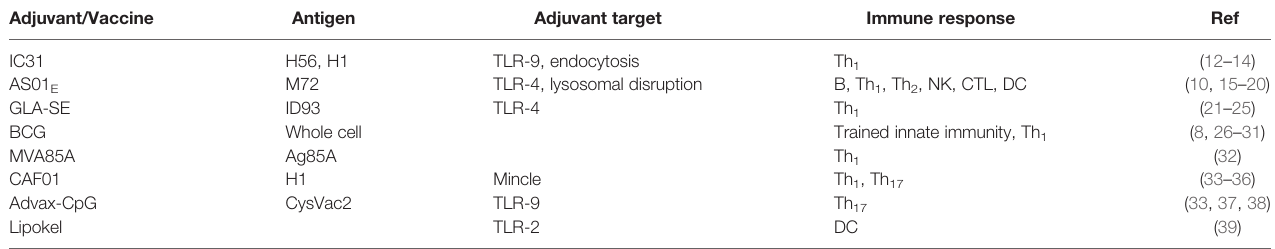
TABLE 1 | Adjuvants Used in Recent TB Vaccine Candidates.